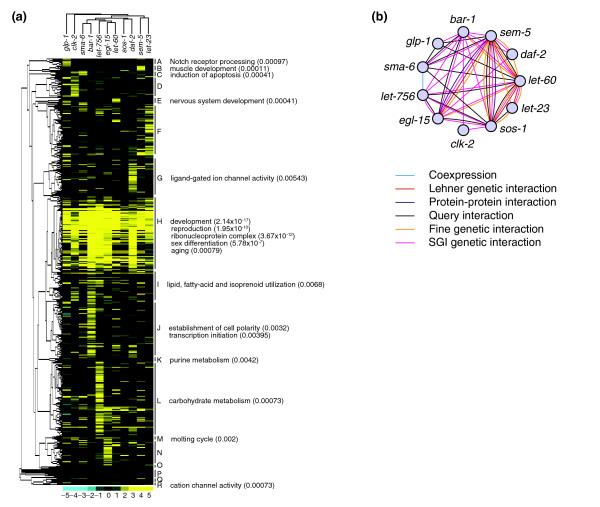
Global patterns of interactions within the SGI network. (a) Two-dimensional clustergram of SGI interactions based on average strength of interaction. RNAi-targeted genes are represented along the rows and the 11 query hypomorphs across the columns. The shades from black to yellow on the bottom scale indicate increasing interaction strength, and shades from black to light-blue indicate increasing alleviating interaction strength. Alleviating interaction strengths indicate that the double reduction-of-function worms grow better than controls. (b) The query network. Query genes (nodes) are linked in this network if they share a significant number of interaction partners or if there is evidence of a functional interaction (see text). Edges are colored according to the type of supporting evidence (see text and Materials and methods for more details). Visualization generated with Cytoscape [85].